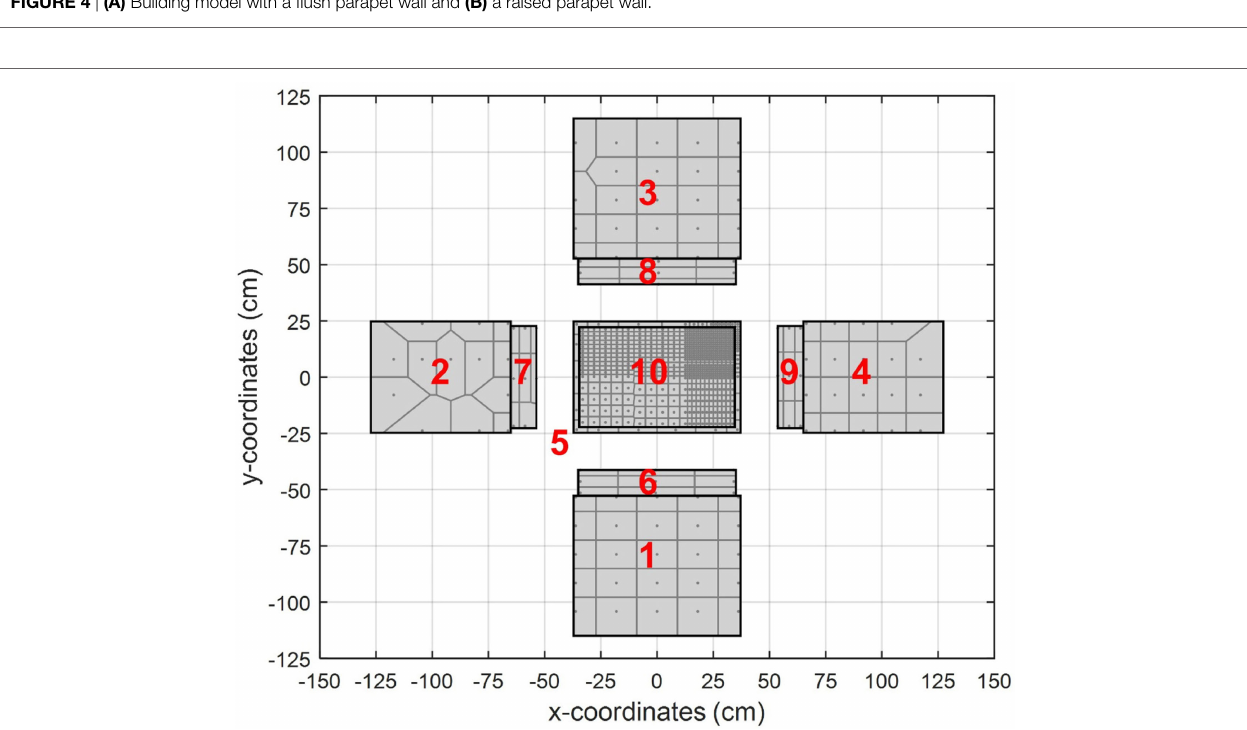
FIGURE 5 | Tap locations, tributary areas, and surface numbers on a flattened representation of the model with a parapet of